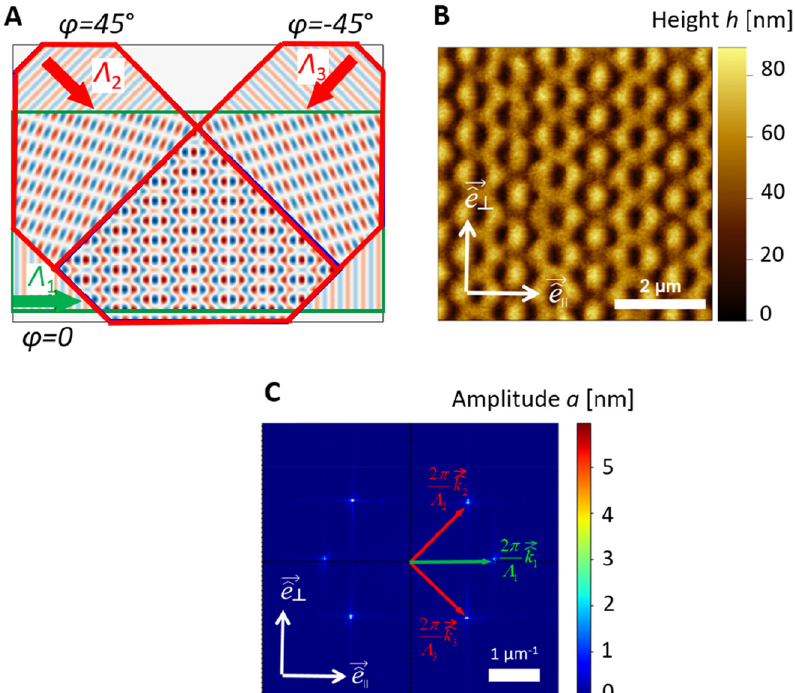
Figure 2: Designed MPG